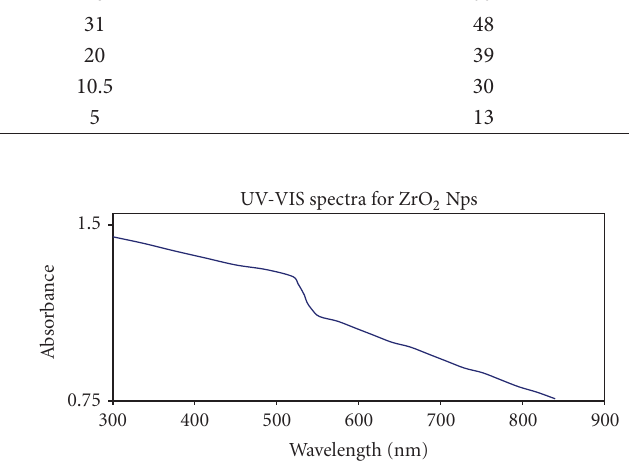
F 2: UV-Vis absorption spectra for ZrO